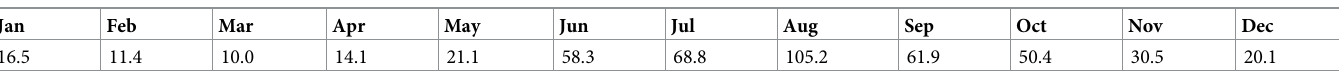
Table 3. Total water inflow in cubic meters.